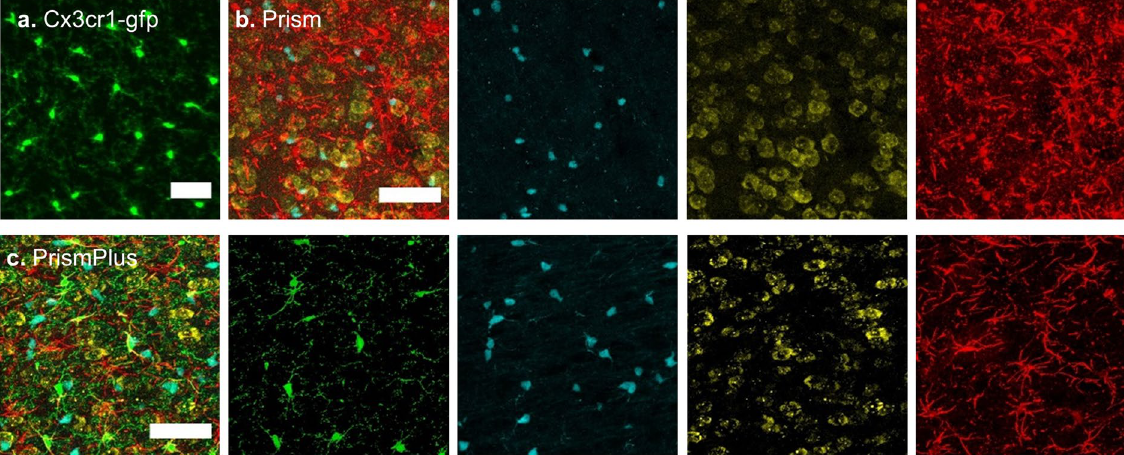
Figure 1. Confocal images of fluorophores expressed in four cell types in the cortex (approximately layer III-IV) of different mouse lines. ( a ) Green fluorescent protein (GFP) is expressed in microglia of Cx3cr1-gfp mouse. ( b ) Merged image of Cyan fluorescent protein (CFP) expressed in oligodendrocytes, yellow fluorescent protein (YFP) expressed in neurons and Discosoma sp . red fluorescent protein (DsRed) expressed in astrocytes of Prism mouse. ( c ) Merged image of CFP expressed in oligodendrocytes, GFP expressed in microglia, YFP expressed in neurons and DsRed expressed in astrocytes of quadruple-colored ‘PrismPlus’ mouse line. Single channel images from Prism and PrismPlus mouse lines are shown right to the merged images, b & c, respectively. Z-stack images of 20 microns thick sections were acquired either sequentially ( a ) or in lambda mode ( b , c ) using Zeiss LSM 710, 20x/0.8 NA objective and are presented as maximum projected intensity. Scale bar = 50 µ